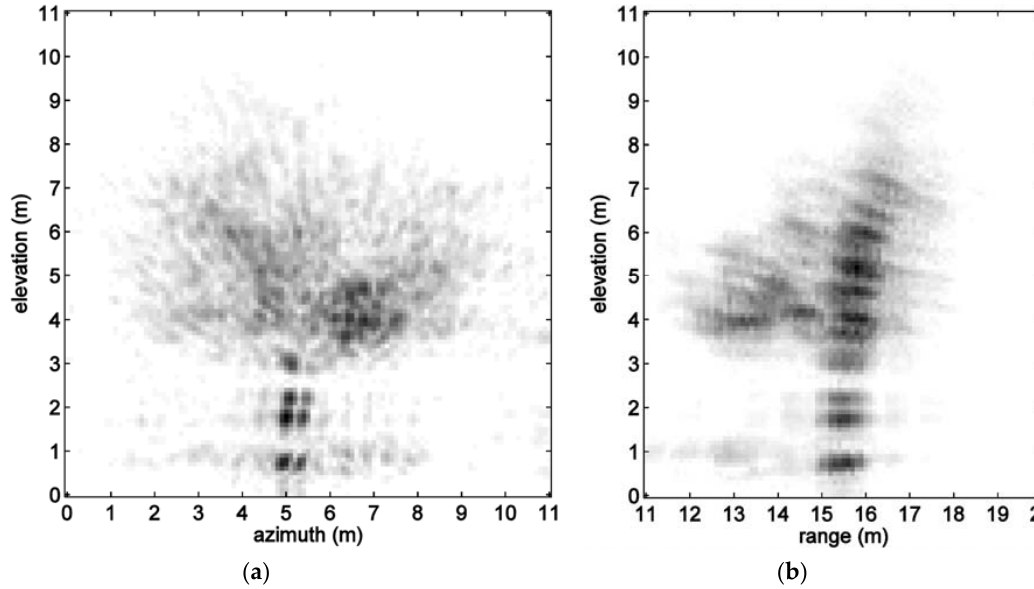
Figure 8. Slices through 3D backscattering image of tree shown in Figure 7. ( a ) Front view; ( b ) side view. Due to the loss of a major limb on the backside of the tree due to storm damage, the tree canopy is concentrated on the forward side of the trunk. Multipath from the ground between the radar and tree distorts the image of the trunk. The reversed linear image color scale extends from white for low backscatter to black for high backscatter. The linear grayscale is arbitrary.